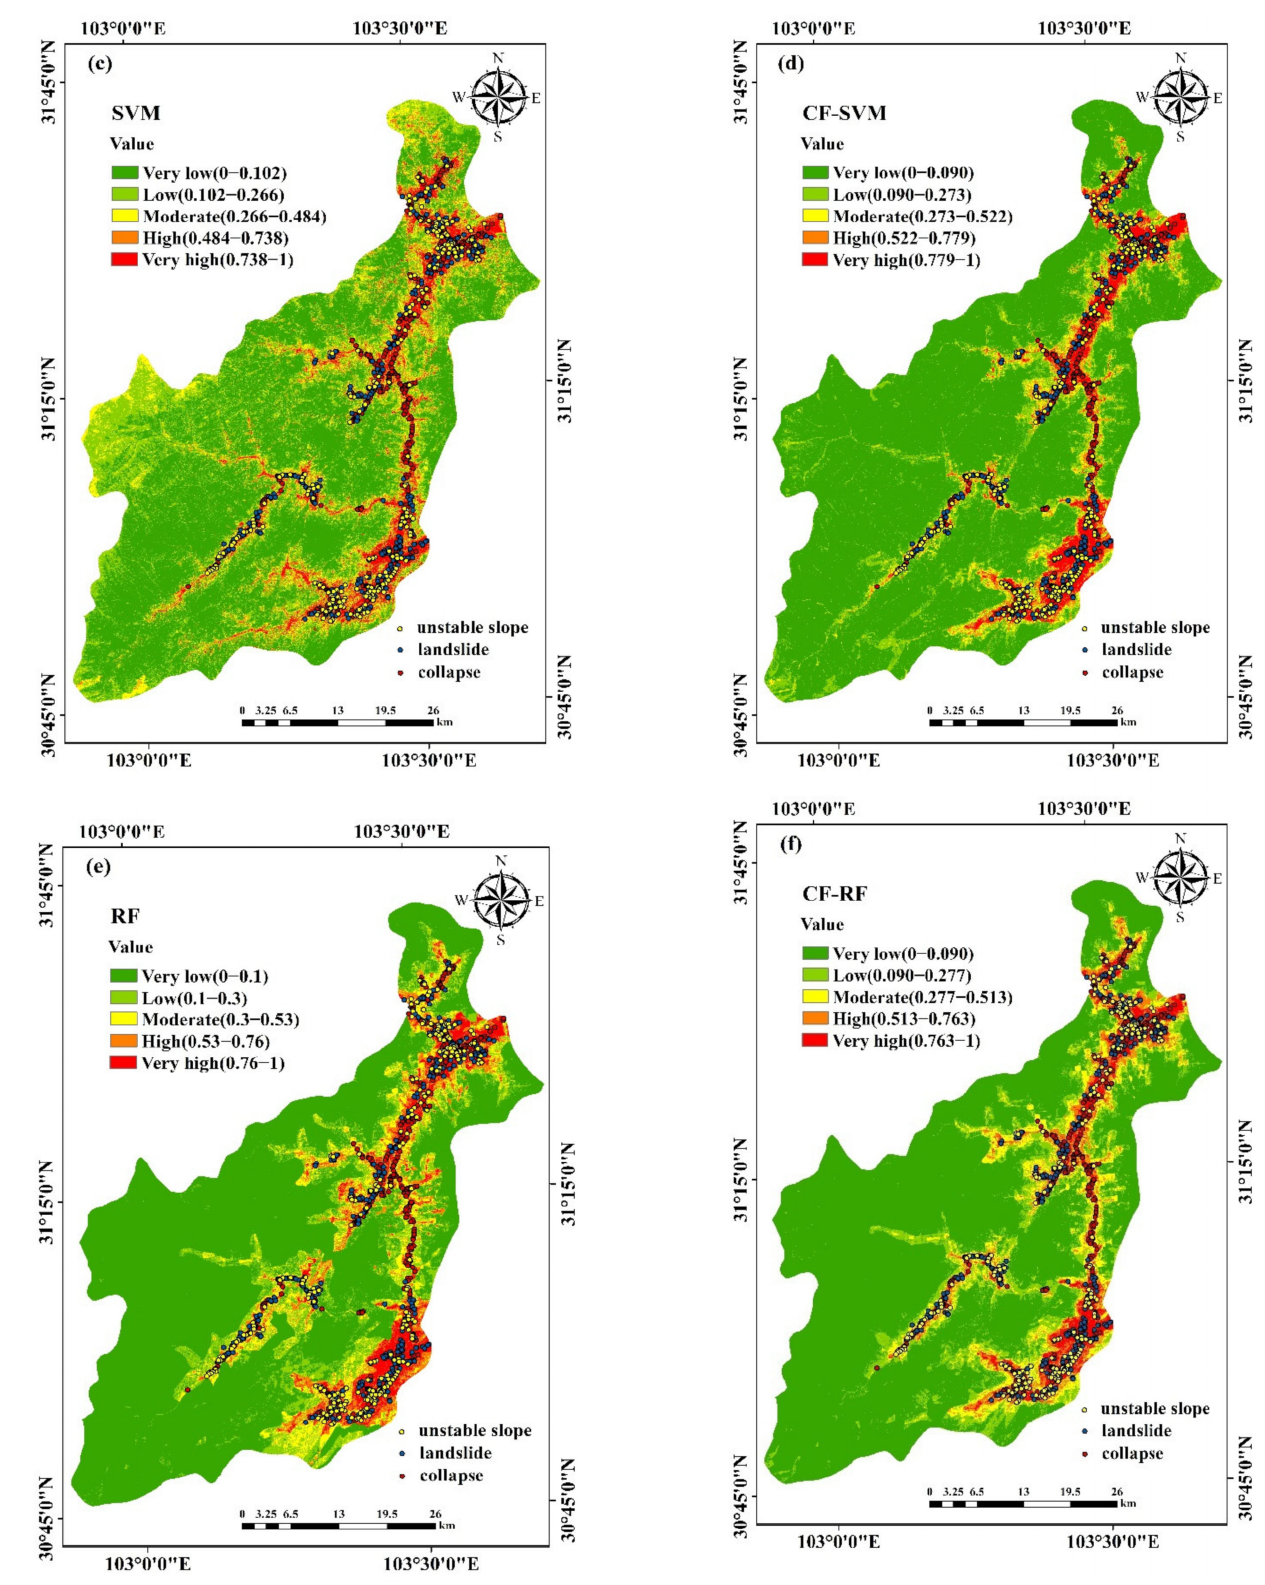
Figure 6. Collapse and landslide susceptibility mapping of different models: ( a ) LR, ( b )